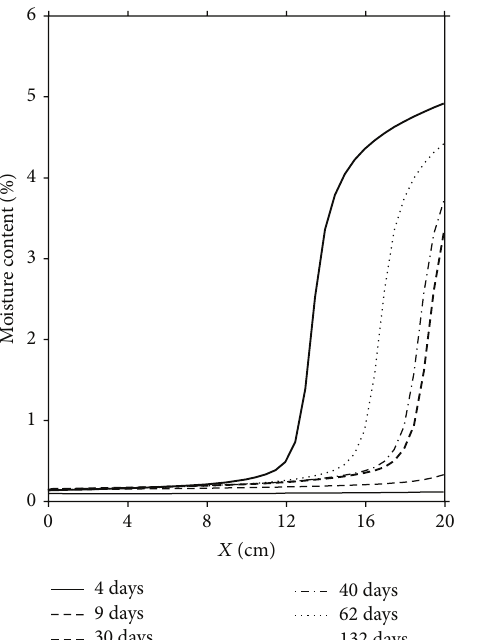
Figure 2: Distributions of moisture content. Numerical simulation results.